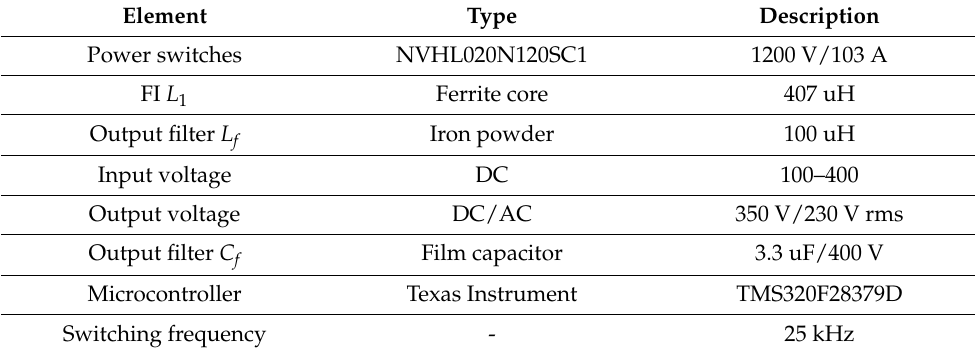
Table 2. Passive elements and components used in the experimental